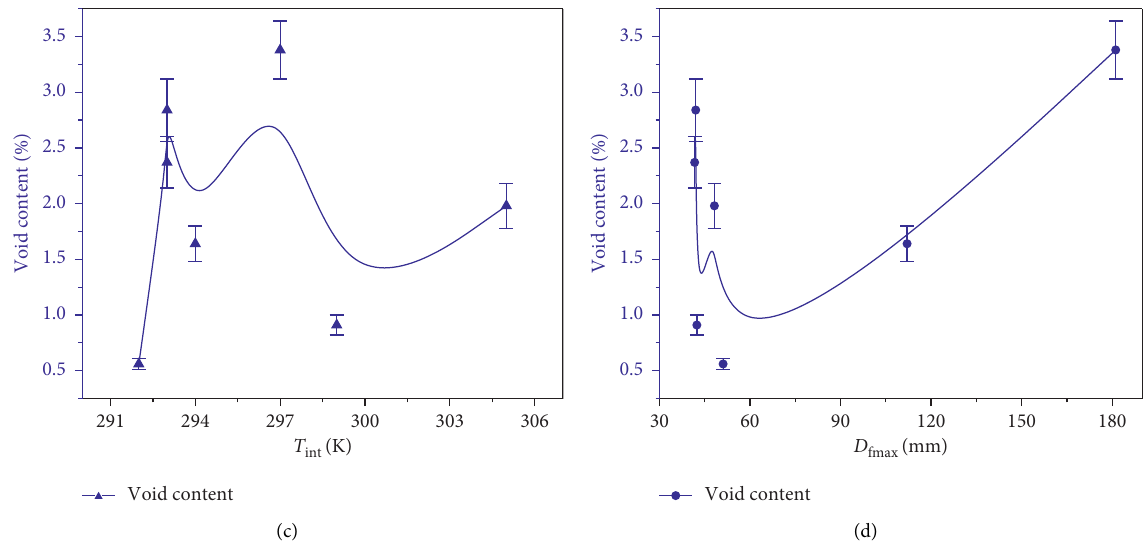
bm ). (b) Maximum cross-